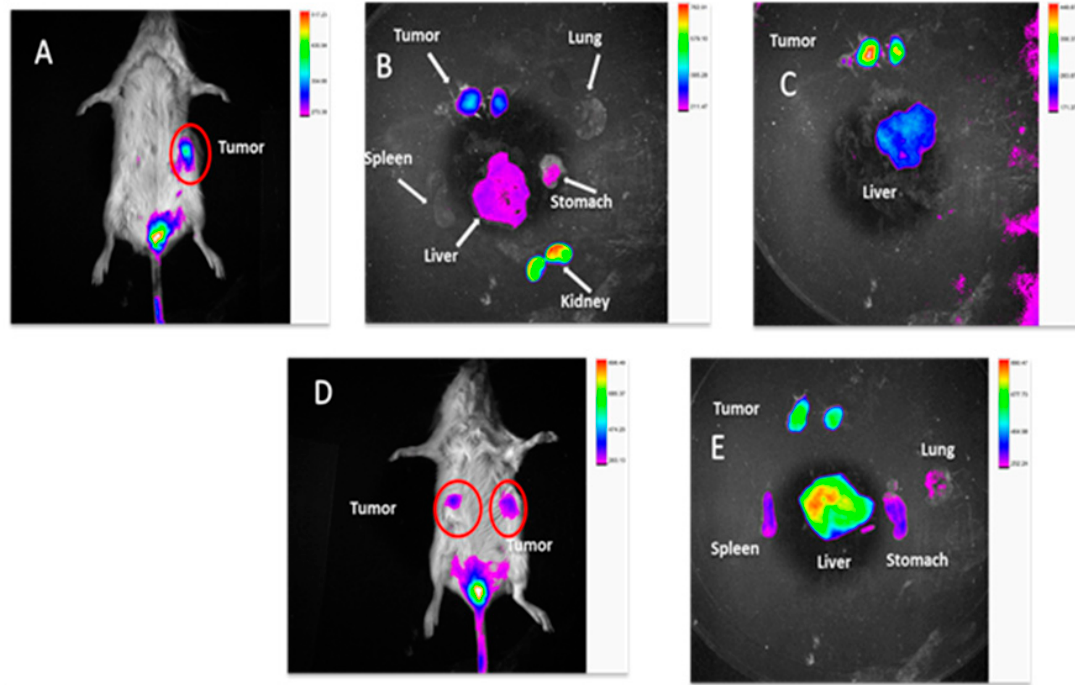
Figure 10. The tumor hypoxia specific imaging of BSA-CDF-ATZ-S0456 in TNBC patient derived tumor xenograft (PDX) Nod / SCID mice. ( A ) The extent of tumor targeting via hypoxia in mice; ( B ) The bio-distribution of the targeted formulation in the organs; ( C ) Comparative bio-distribution of the targeted formulation in liver and tumor; ( D , E ) the extent of tumor targeting via hypoxia for the non-targeting drug delivery system BSA-CDF in mice and the bio-distribution respectively.